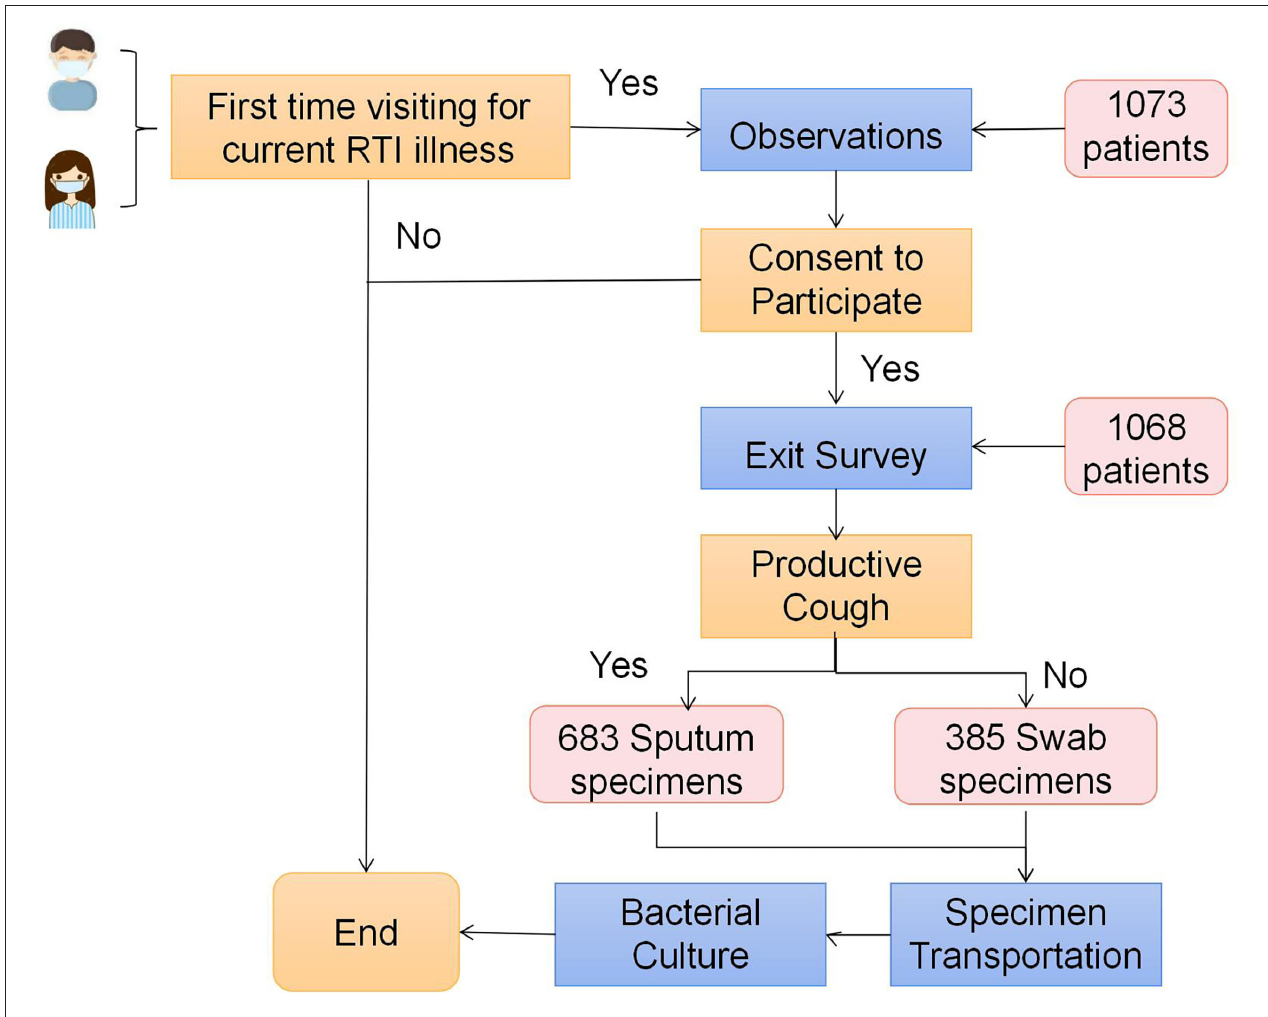
FIGURE 1 | Flow chart of participant